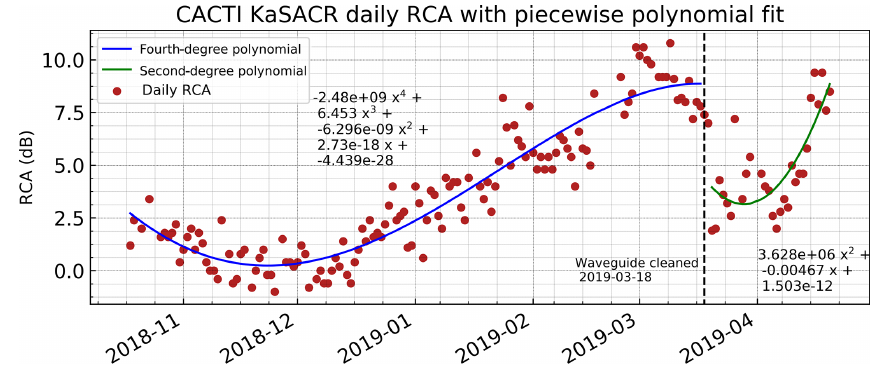
Figure 18. The RCA daily values for the CACTI KaSACR radar are shown with a corresponding piecewise polynomial fit. A decreasing trend in power resulted in an increasing trend in the RCA value. On 18 March 2019, the waveguide had an obstruction removed, and a sharp decrease (due to corresponding increase in effective power) can be observed. As such a new polynomial fit is calculated for this time period. However, the general trend of decreasing power and increasing RCA continues. The fit is given relative to the epoch time in seconds of each day.